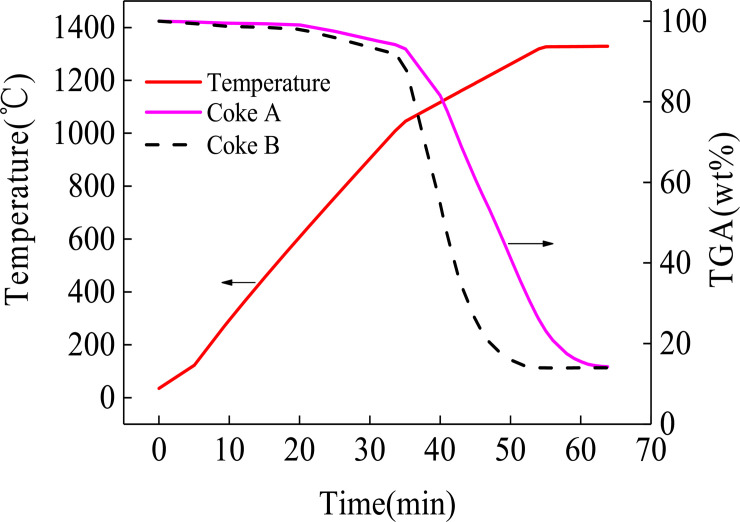
Coke reaction with CO2 at 1100–1350°C.